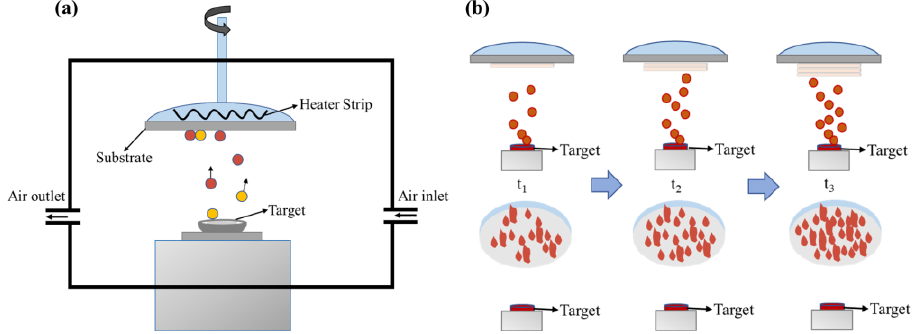
Figure 1. The diagram of preparing mineral anti-fog film materials. ( a ) Device diagram of vacuum evaporation coating machine; ( b ) growth of films with different